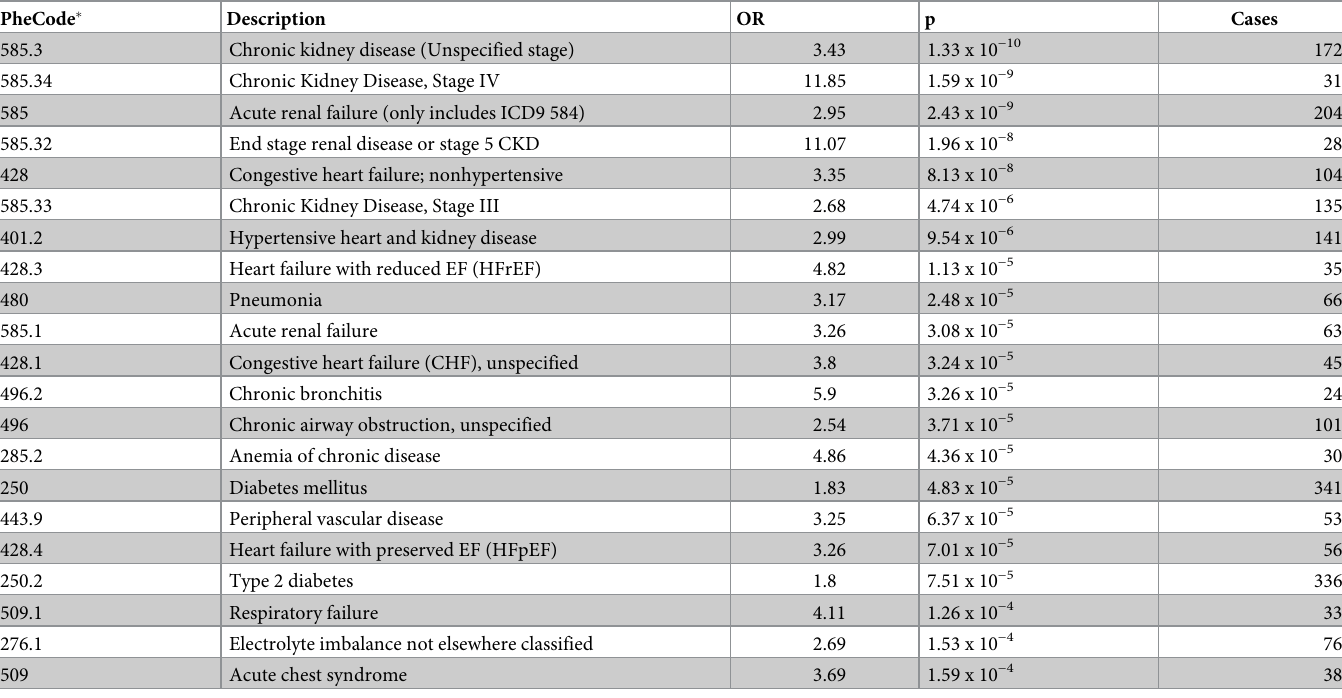
Table 2. Summary data for clinical phenotypes significantly associated with COVID-19 associated hospitalization adjusted for age, sex and race. PheCode